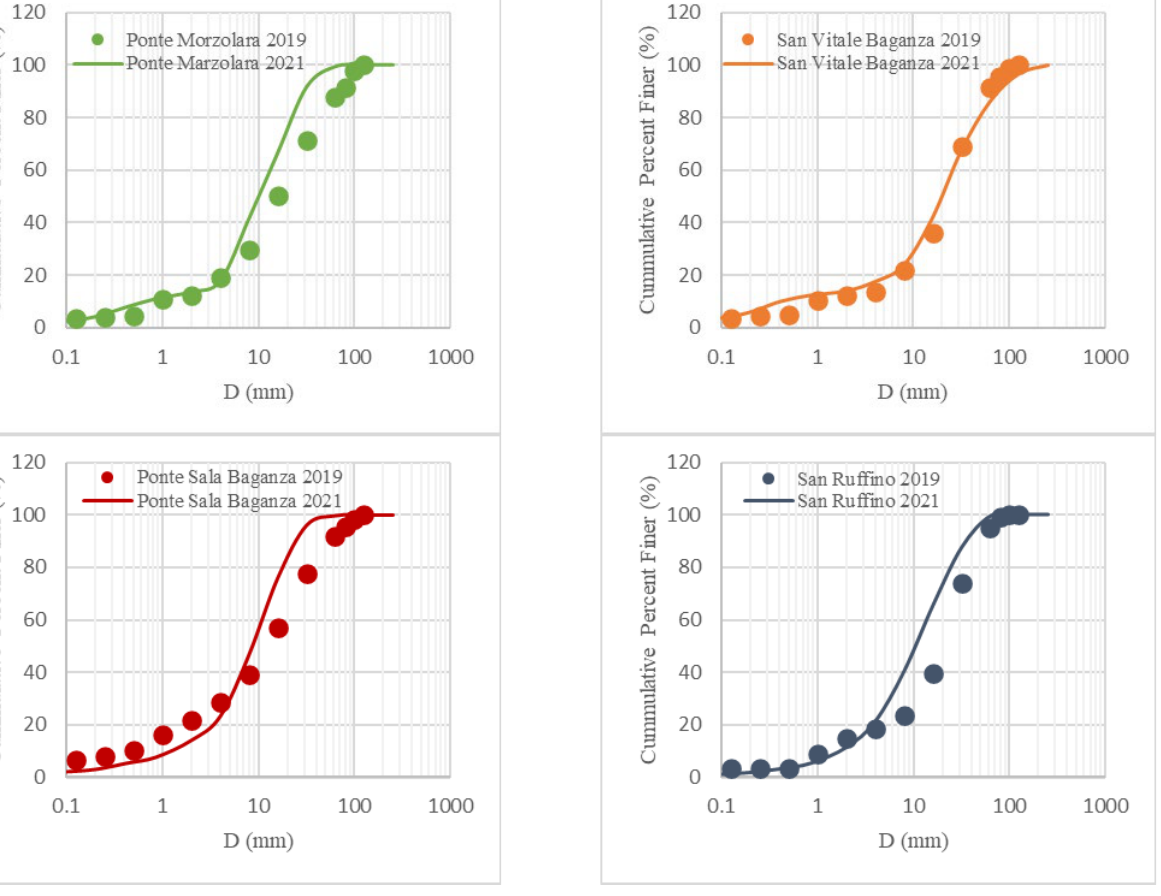
Figure 13. The GSD yield from the fusion of both the photogrammetry and in situ sieving temporal comparison.